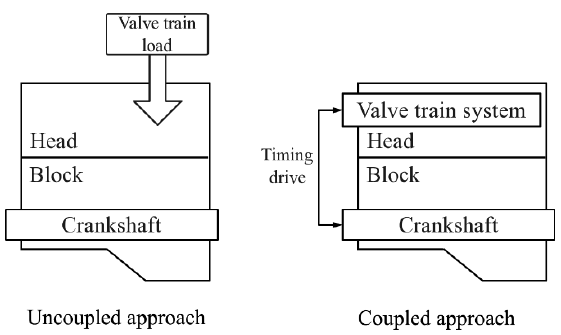
Figure 11. Differences between the uncoupled and coupled approach.